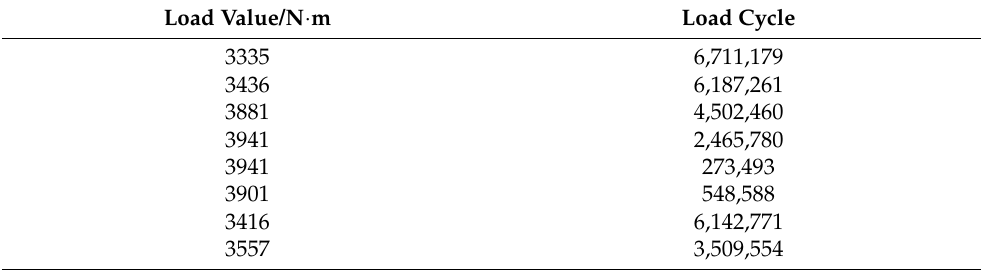
Table 5. Fatigue experimental results of crankshaft N0.